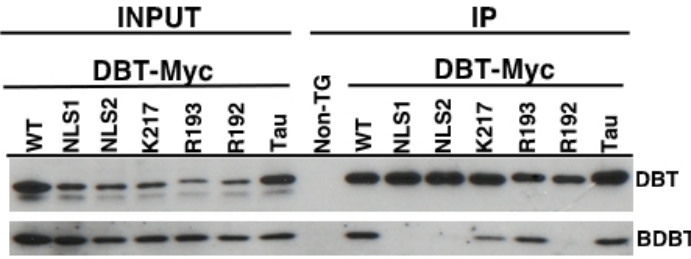
Figure 4. Co-immunoprecipitation analysis of DBT-MYC and BDBT. The indicated transgenic proteins were expressed in flies with the timGAL4 driver, heads were collected at ZT7, extracts prepared, and DBT-MYC was immunoprecipitated with an anti-MYC antibody. In an immunoblot analysis, DBT was detected in the crude homogenates (input) and IPs with an anti-DBTC antibody (top), and BDBT was detected in the same samples with an anti-BDBT antibody (bottom). The DBT TAU line has been previously described [10,21] and shows co-immunoprecipitation of DBT and BDBT along with the K217N and R193N constructs. Non-TG = non-transgenic (no MYC tag on DBT). The result is representative of six replicates with different sample collections.